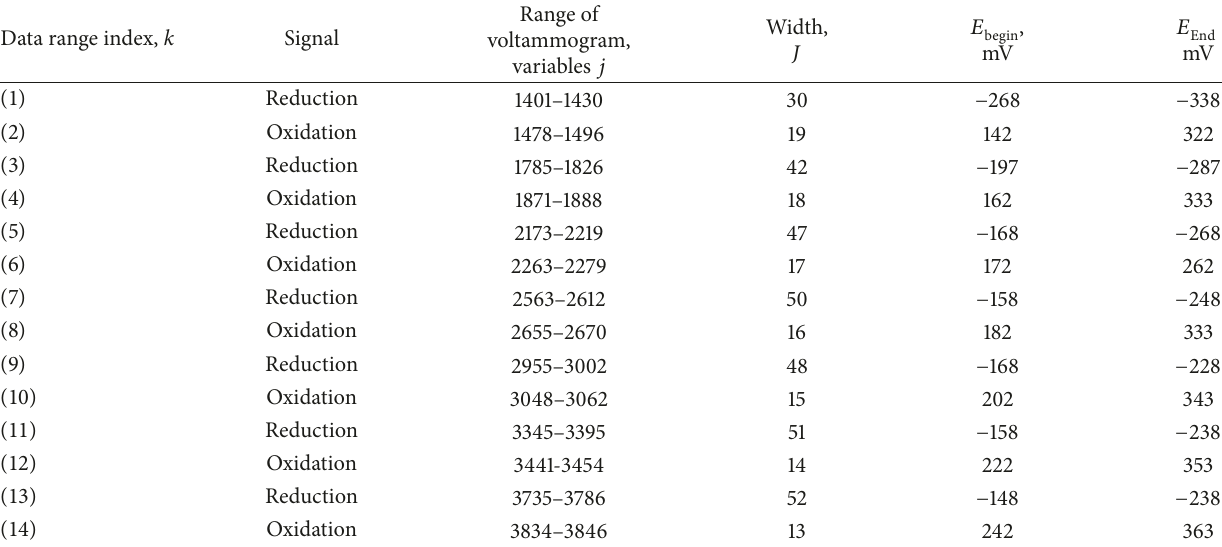
Table 4: Individual (range by range) selection of the ranges of points of staircase voltammogram, variables 𝑗 , of Figure 1 determined based on results of Figure 3. The potentials are expressed versus 𝐸 Data range index, k